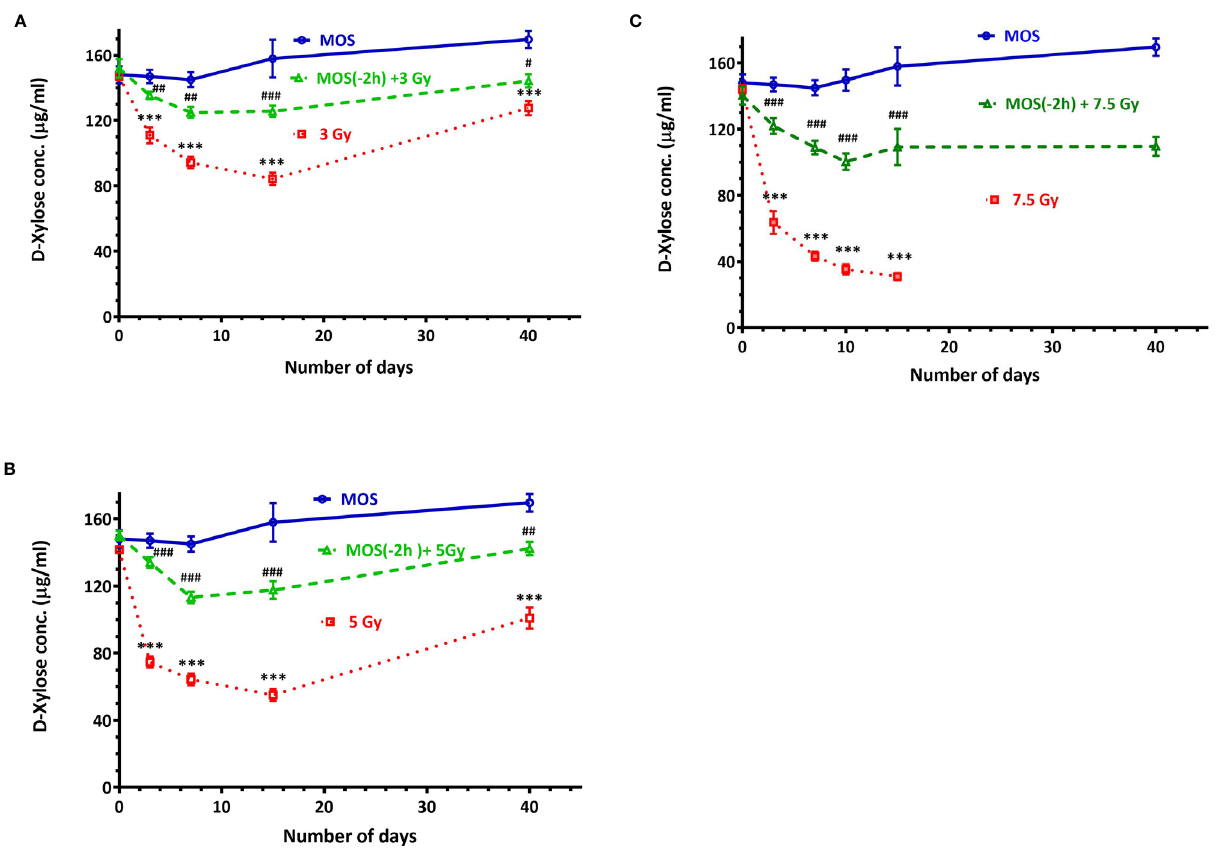
FIGURE 6 | D-Xylose absorption assay: Mice were treated with MOS (200 mg/kg bw) and/or subjected to (A) TBI (3 Gy) and assessed for absorptive capacity of the small intestine on days 0, 3, 7, 15, and 40; (B) TBI (5 Gy) assessed for absorptive capacity of the small intestine on days 0, 3, 7, 15, and 40; (C) TBI (7.5 Gy) assessed for absorptive capacity of the small intestine on days 0, 3, 7, 10, 15, and 40 post TBI as described in Materials and Methods . Error bars represent mean ± SD, *** p < 0.001 were considered signi fi cant compared to un-irradiated control group and ### p < 0.001were considered signi fi cant compared to irradiated